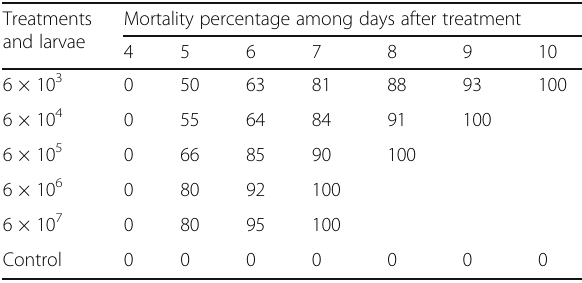
Table 2 Mortality percentage among adults of Rhynchophorus ferrugineus treated with different concentrations of